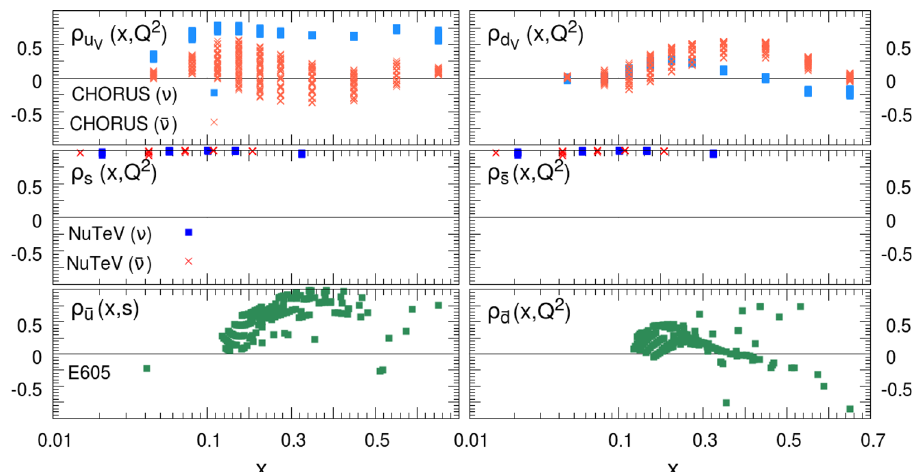
NuTeV along all the measured range, 0 . 02 ≤ x ≤ 0 .